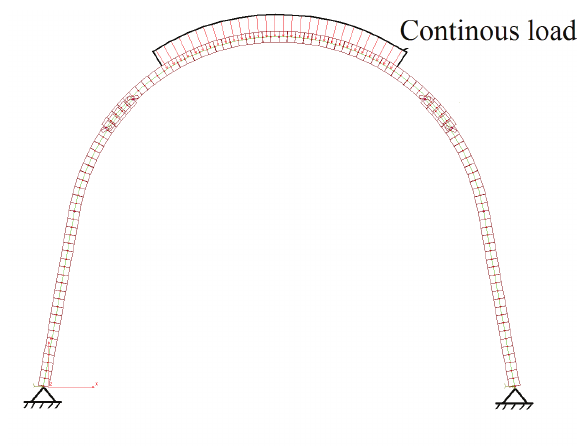
Figure 5: Variant I of the load on the frame.